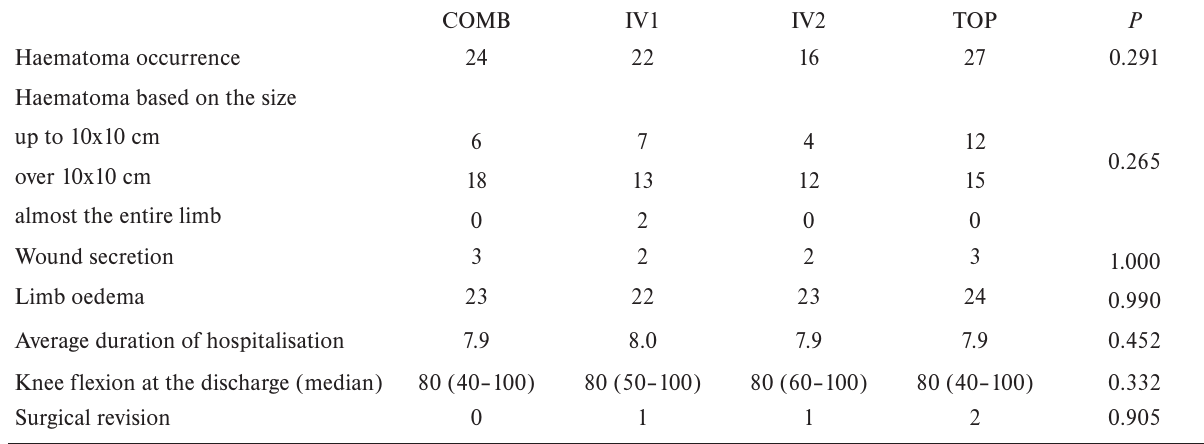
Table 6. Comparison of hospitalization complications – haematoma, secretion, swelling,